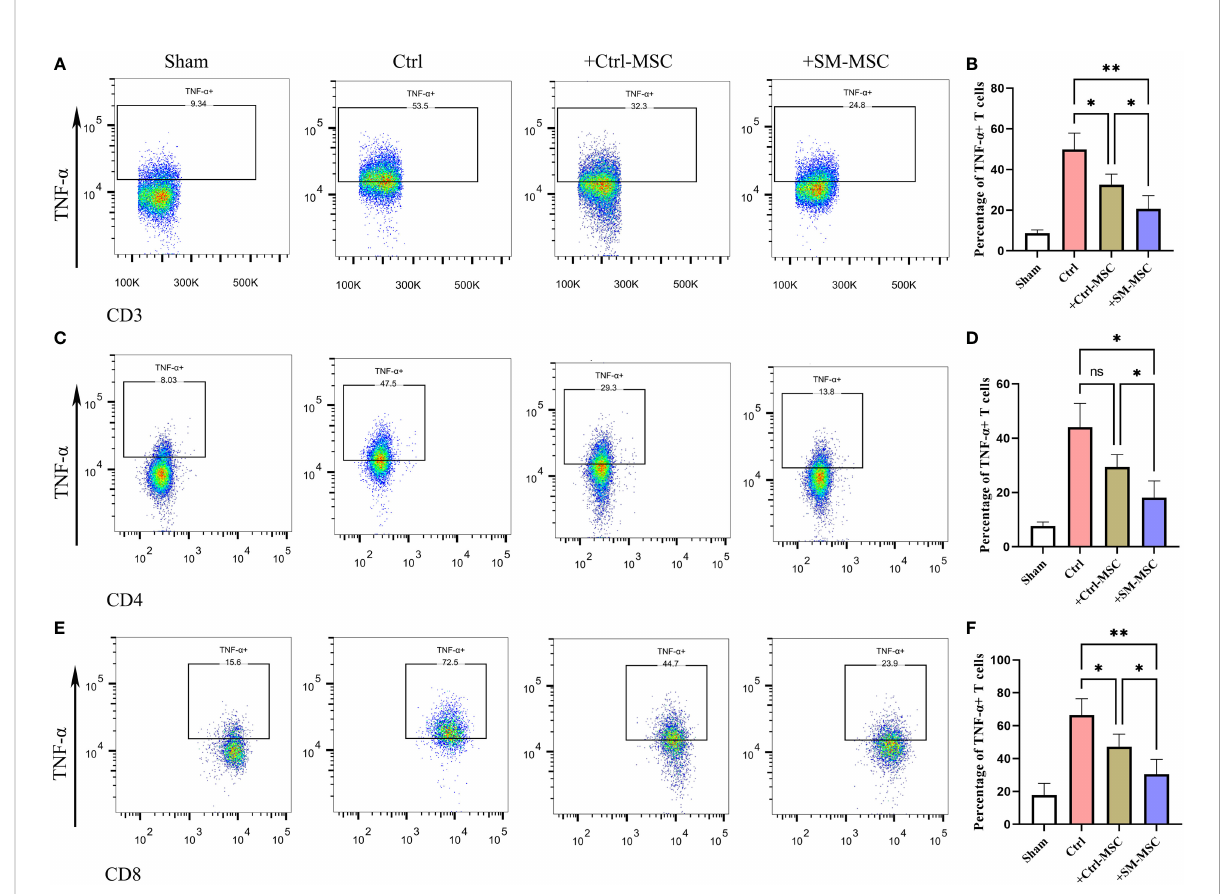
FIGURE 5 Comparison of in fl ammatory T cell in cervical lymph nodes. Analysis of TNF- a -producing CD3 (A, B) , CD4 (C, D) and CD8 (E, F) positive T cells within cervical lymph nodes, n = 5 per group. Data are shown as mean ± SD, *P < 0.05, **P < 0.01, and ns means not signi fi